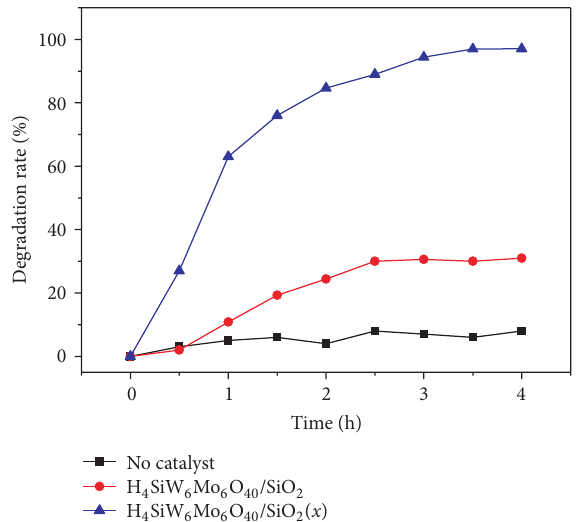
Figure 5: Comparison of photocatalytic activity of catalysts.